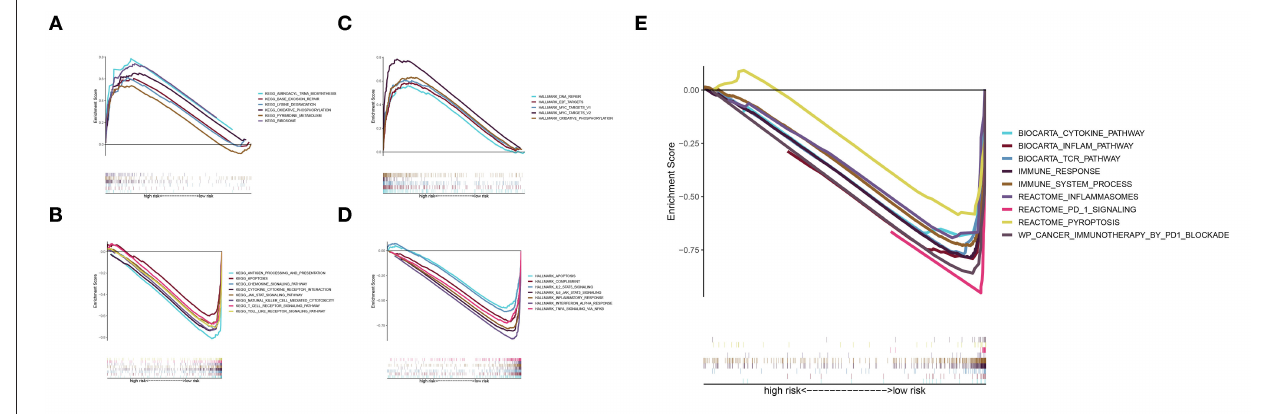
FIGURE 6 | GSEA. (A) KEGG pathways of the signature in the high-risk group. (B) KEGG pathways of the signature in the low-risk group. (C,D) Hallmark pathway analysis revealed pathways enriched in the high-risk group (C) and low-risk group (D) . (E) Enrichment analysis of pyroptosis, immune-related, and inflammatory response-related pathways in the low-risk